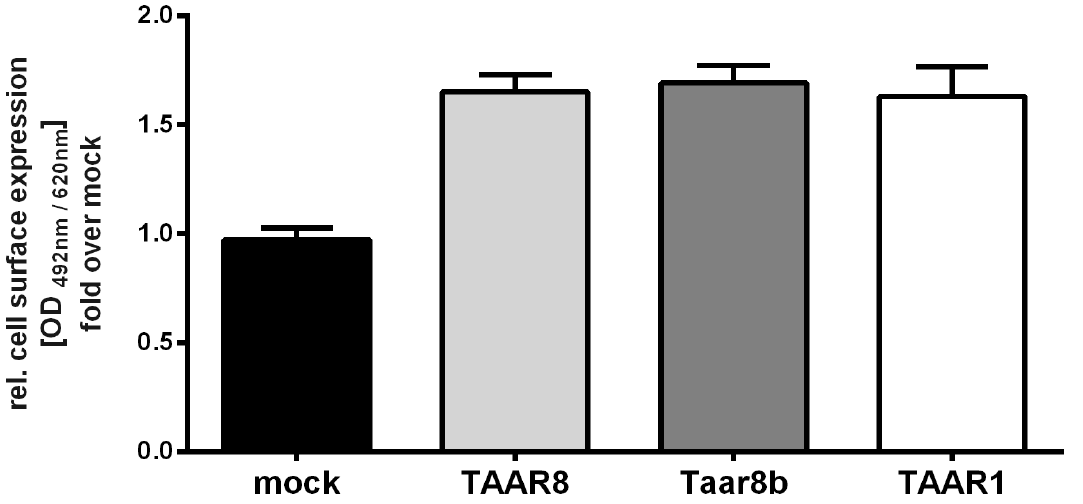
Figure 3. Cell surface expression of TAAR8. Cell surface expression was determined in COS-7 cells by ELISA as described in the methods section. Data are represented as mean ± SEM fold over mock (0.02 ± 0.001) (black) relative cell surface expression, measured at OD 492/620 nm and based on three to six independent experiments with six replicates each. TAAR8 (light grey), Taar8b (dark grey) and human TAAR1 (white) showed comparable surface expression. The human β2-adrenergic receptor (ADRB2) served as a positive control, demonstrating expression levels of 23.72 ± 1.59 (mean OD 492/620 nm ± SEM, fold over basal